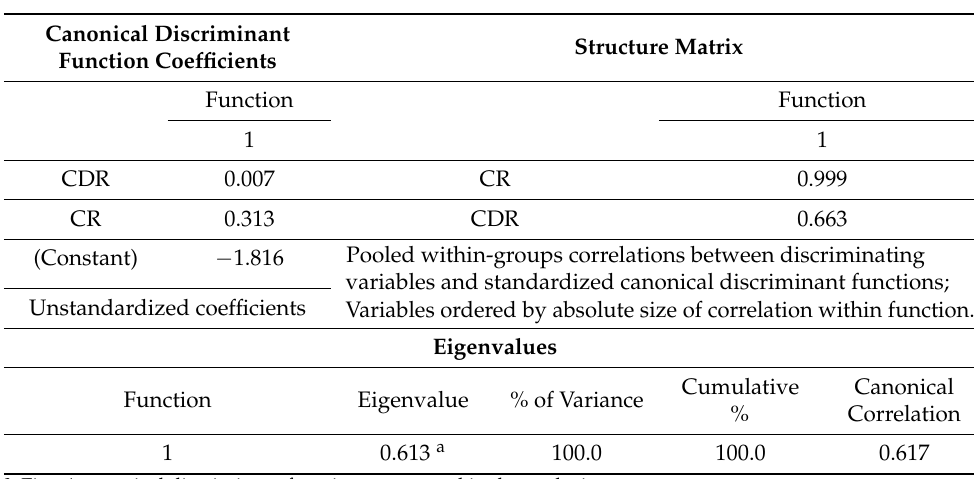
Table A10. Final LDA Model.